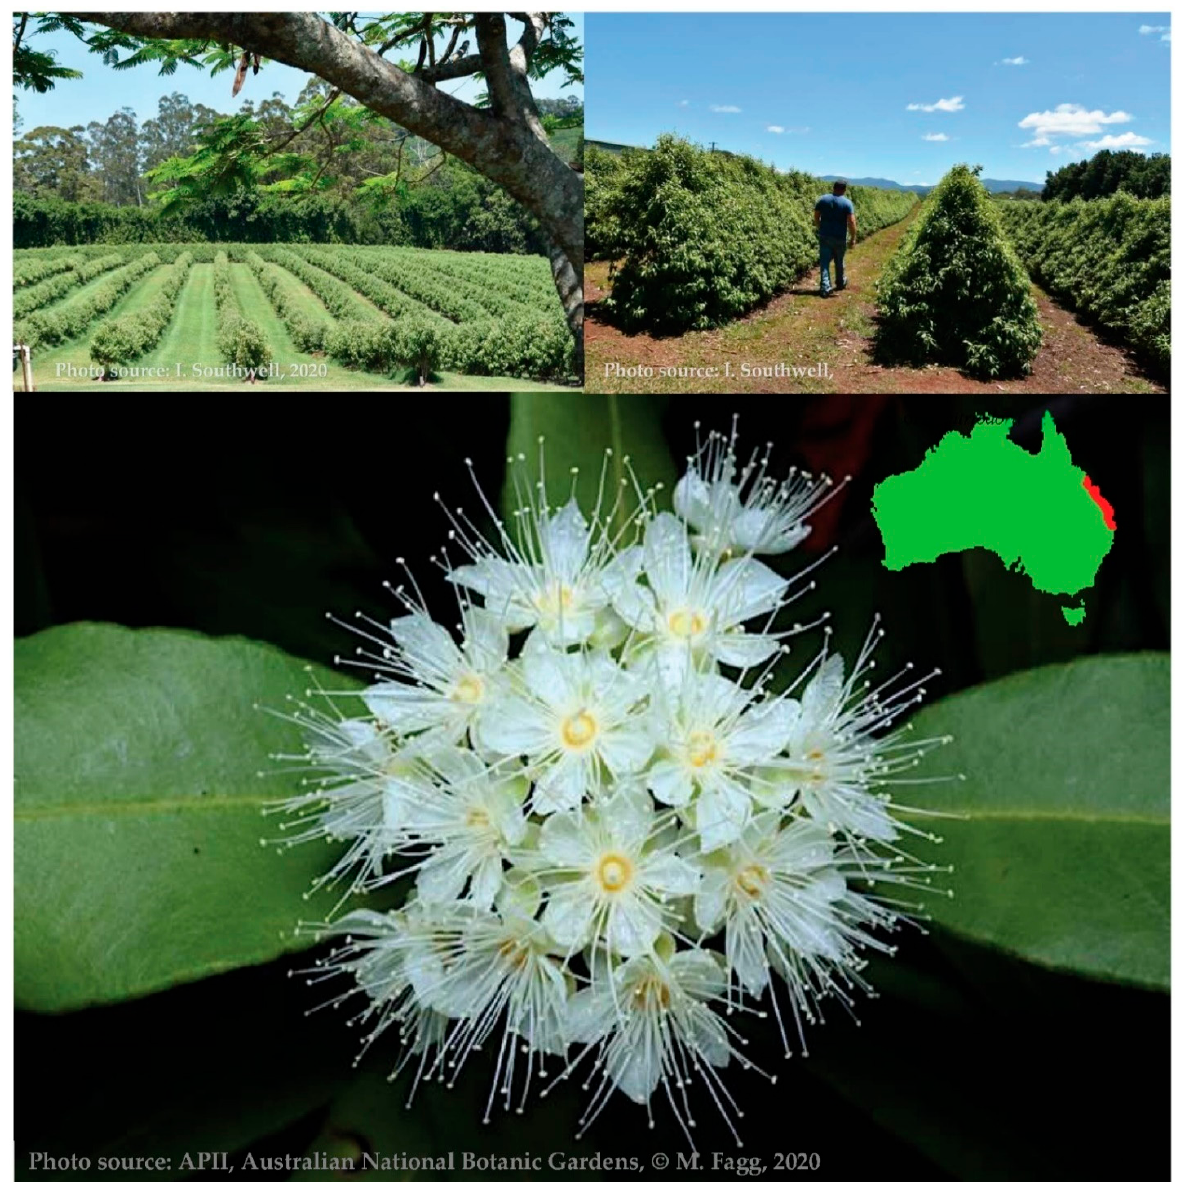
Figure 1. Backhousia citriodora in plantation and in flower, showing natural distribution.